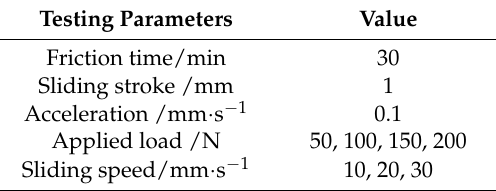
Table 3. Friction test